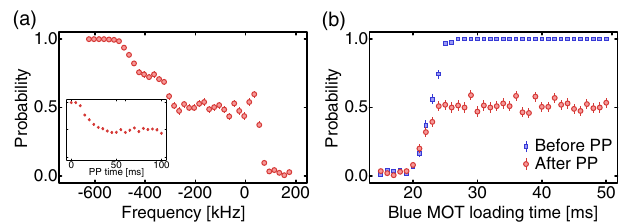
FIG. 8. Preparing single atoms via parity projection. (a) The probability of detecting an occupied tweezer after a parity projection (PP) pulse of 60 ms varies with the detuning of the addressing frequency. The highest step on the left corresponds to the situation when the PP pulse is detuned away from any atomic or molecular resonance, such that many atoms remain in the trap. The lowest step on the right corresponds to the heating on blue- detuned motional sidebands, which expels atoms out of the trap. The plateau in the middle corresponds to the PP region where the occupation probability is 0.5. Inset: The probability of detecting an occupied tweezer monotonically decreases and saturates to 0.5 as the duration of the PP pulse increases. (b) As the blue MOT loading time increases, the initial number of atoms in the tweezer increases, such that the probability of detecting an occupied tweezer approaches 1.0 before PP (blue squares), but saturates to 0.5 after a PP pulse (red circles). The frequency detuning from free-space resonance here is − 226